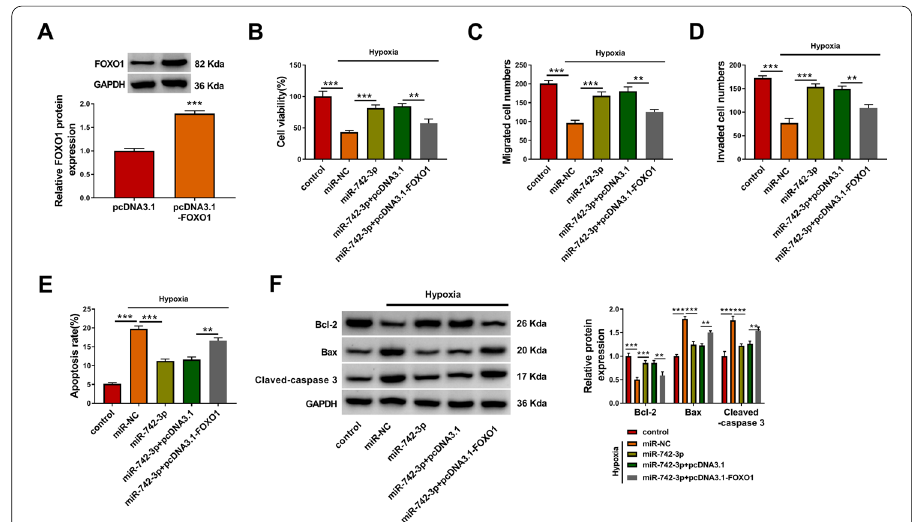
Fig. 7 Effects of miR-742-3p and FOXO1 on hypoxia-induced H9c2 cell injury. A H9c2 cells were transfected with pcDNA3.1 and pcDNA3.1- FOXO1 , and the protein expression of FOXO1 was detected by WB analysis. B – F H9c2 cells were transfected with miR-NC (50 nM), miR-742-3p (50 nM), miR-742-3p (50 nM) (4.0 µg), or miR-742-3p (50 nM) pcDNA3.1- FOXO1 (4.0 µg), and then treated with hypoxia. Untreated H9c2 + cells were used as control. Cell viability, migrated and invaded cell numbers, and cell apoptosis rate were examine the protein levels of Bcl-2, Bax and Cleaved-caspase 3. All experiments were repeated three times. ** P < 0.01, *** P <